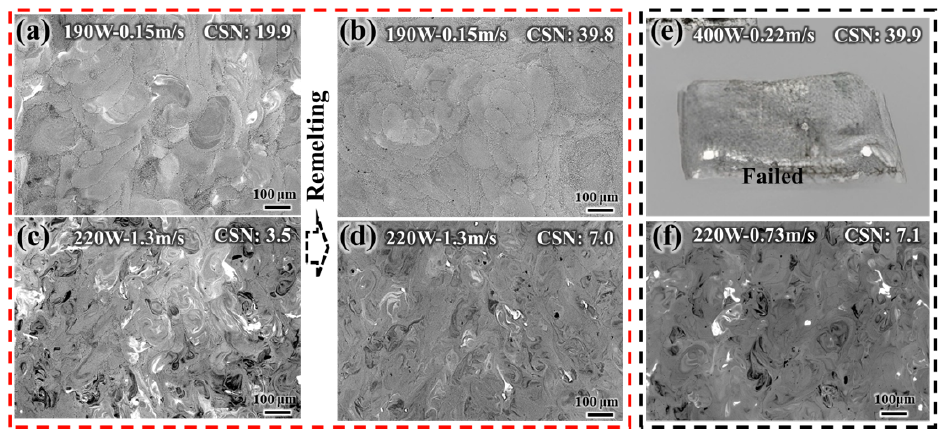
Figure 11. The composition inhomogeneity within the samples to increase CSN by ( a – d ) remelting and ( e – f ) adjusting processing parameters.